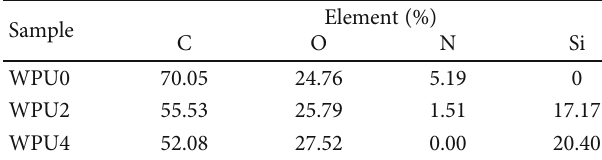
Figure 6: AFM images of (a) WPU0, (b) WPU2, and (c) WPU4. Table 5: Element composition of LEPS-modi fi ed WPU fi